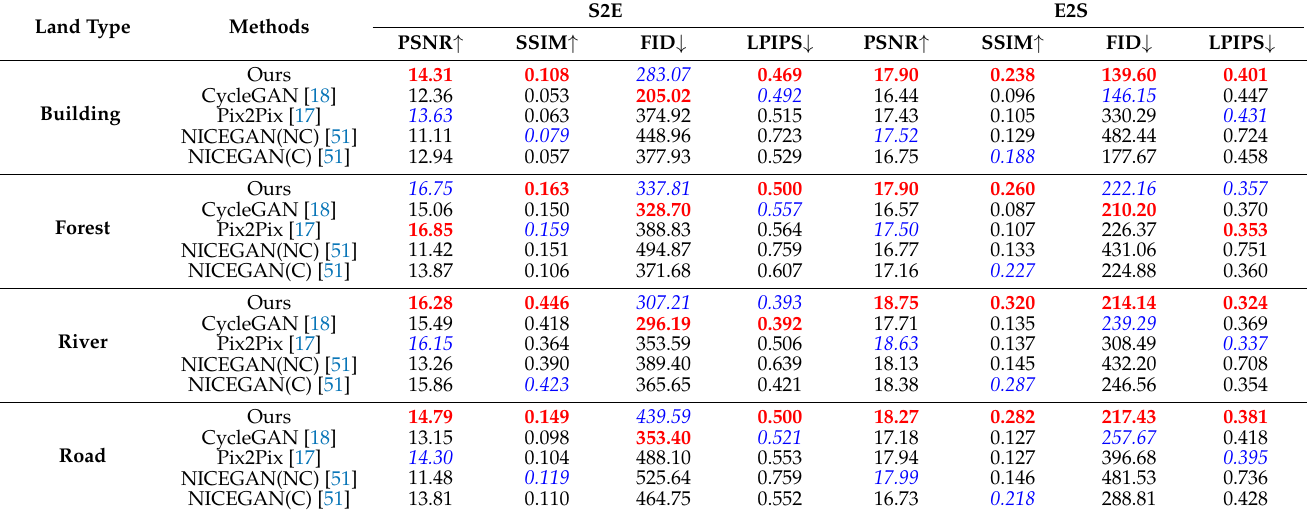
Table 5. Comparisons of IQA scores per category of SN6-SAROPT for S2E (SAR to EO) and E2S (EO to SAR) tasks. The best and second best results are highlighted as red bold and blue italic , respectively.